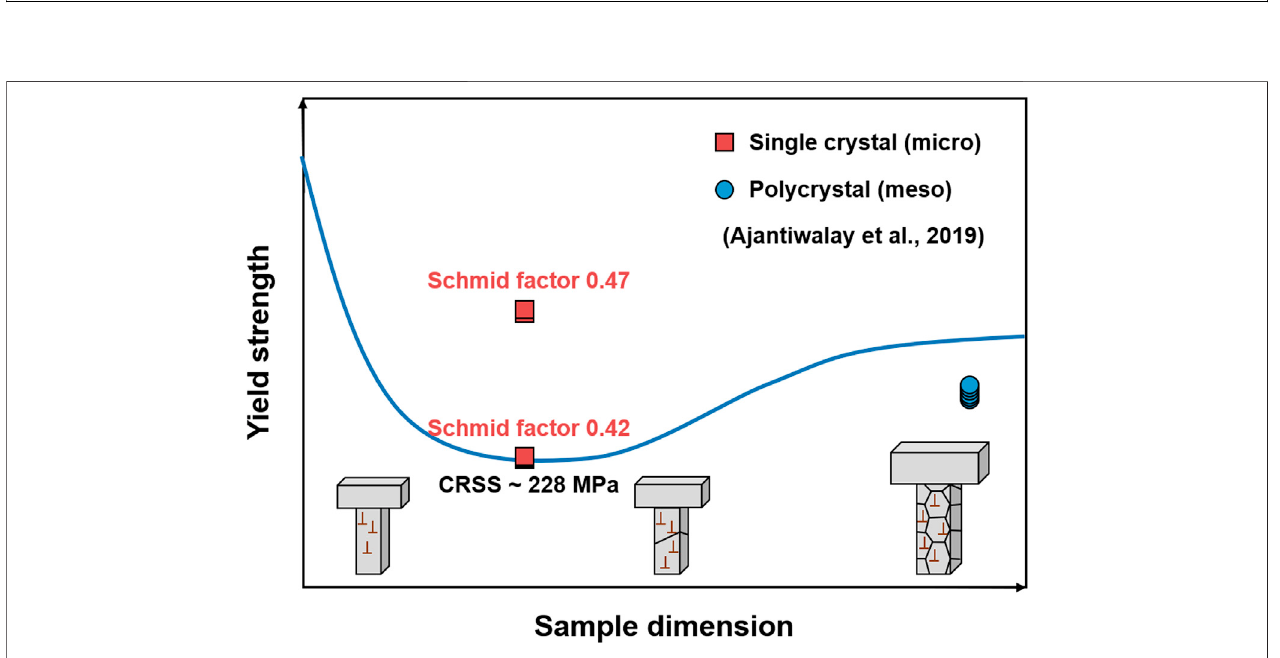
FIGURE 5 | Proposed size effects for unirradiated 304SS, based on micro-tensile tests data adapted from Ajantiwalay et al. (2019).